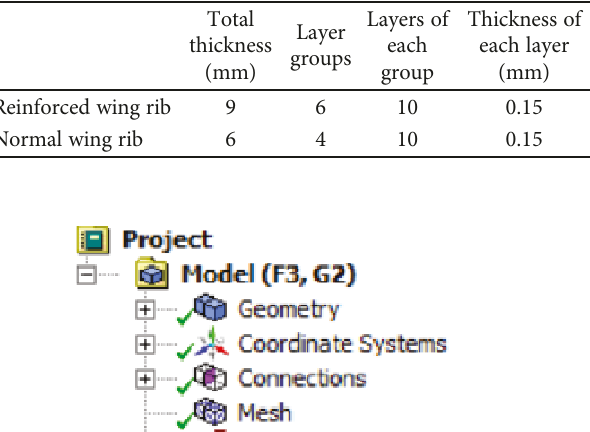
Table 4: The thickness and layer parameters of the ribs.